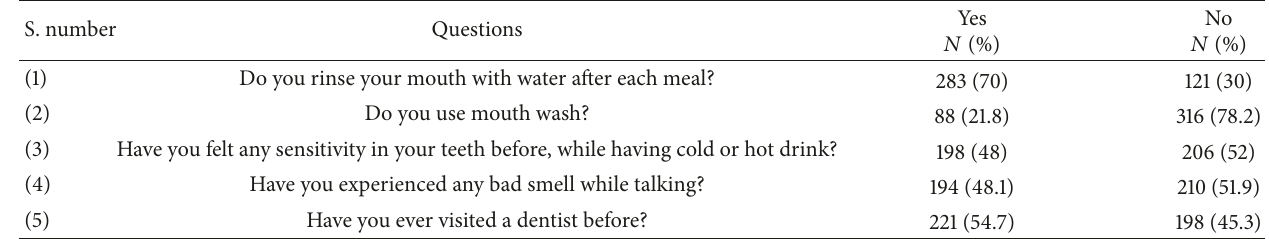
Table 1: Knowledge, attitude, and awareness of oral health among sample population. S.